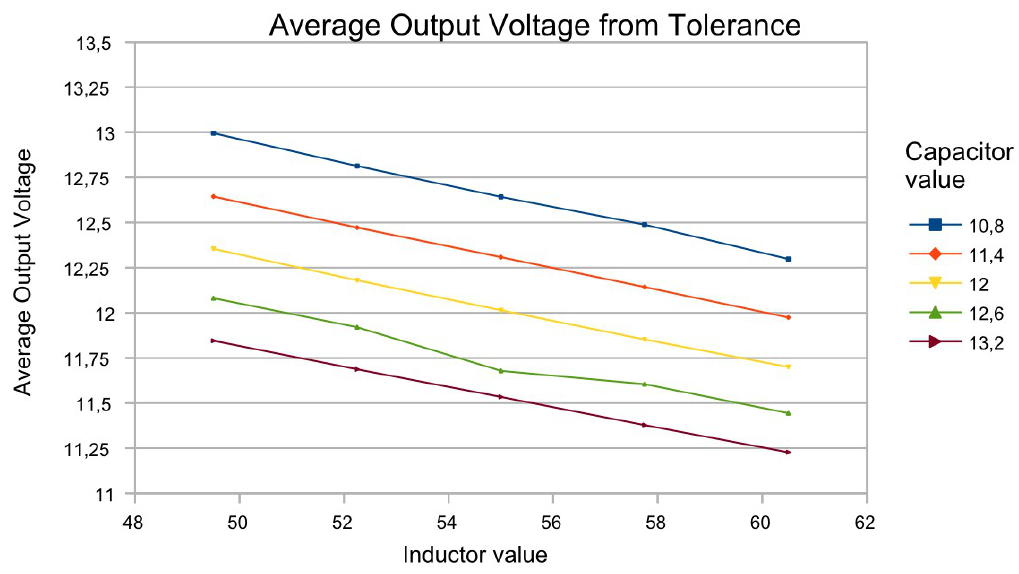
Figure 13. Tolerance analysis of the output voltage ripple with optimized values.